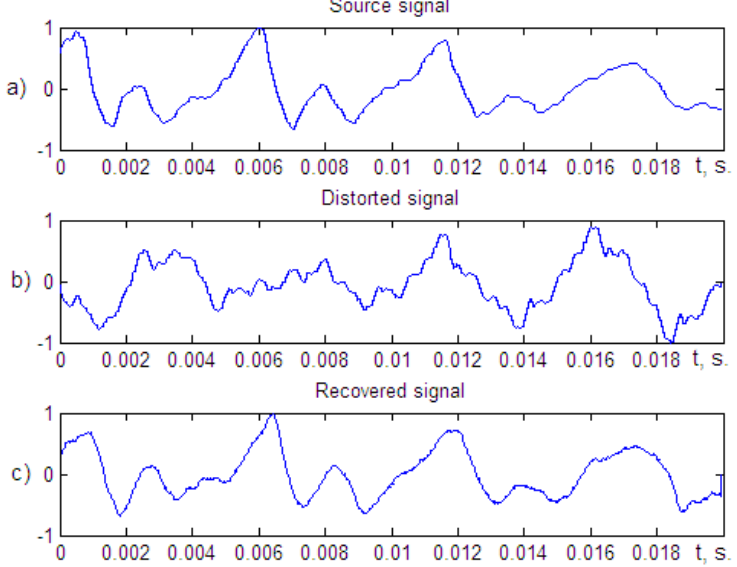
Fig. 4. Results of the blind deconvolution of speech signals. The distorted signal was prewhitened using a fifth order linear prediction